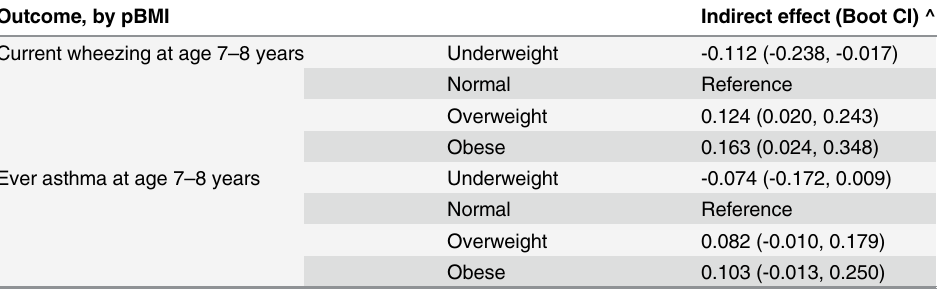
Table 3. Indirect effect of z-score BMI offspring at age 5 years by maternal BMI